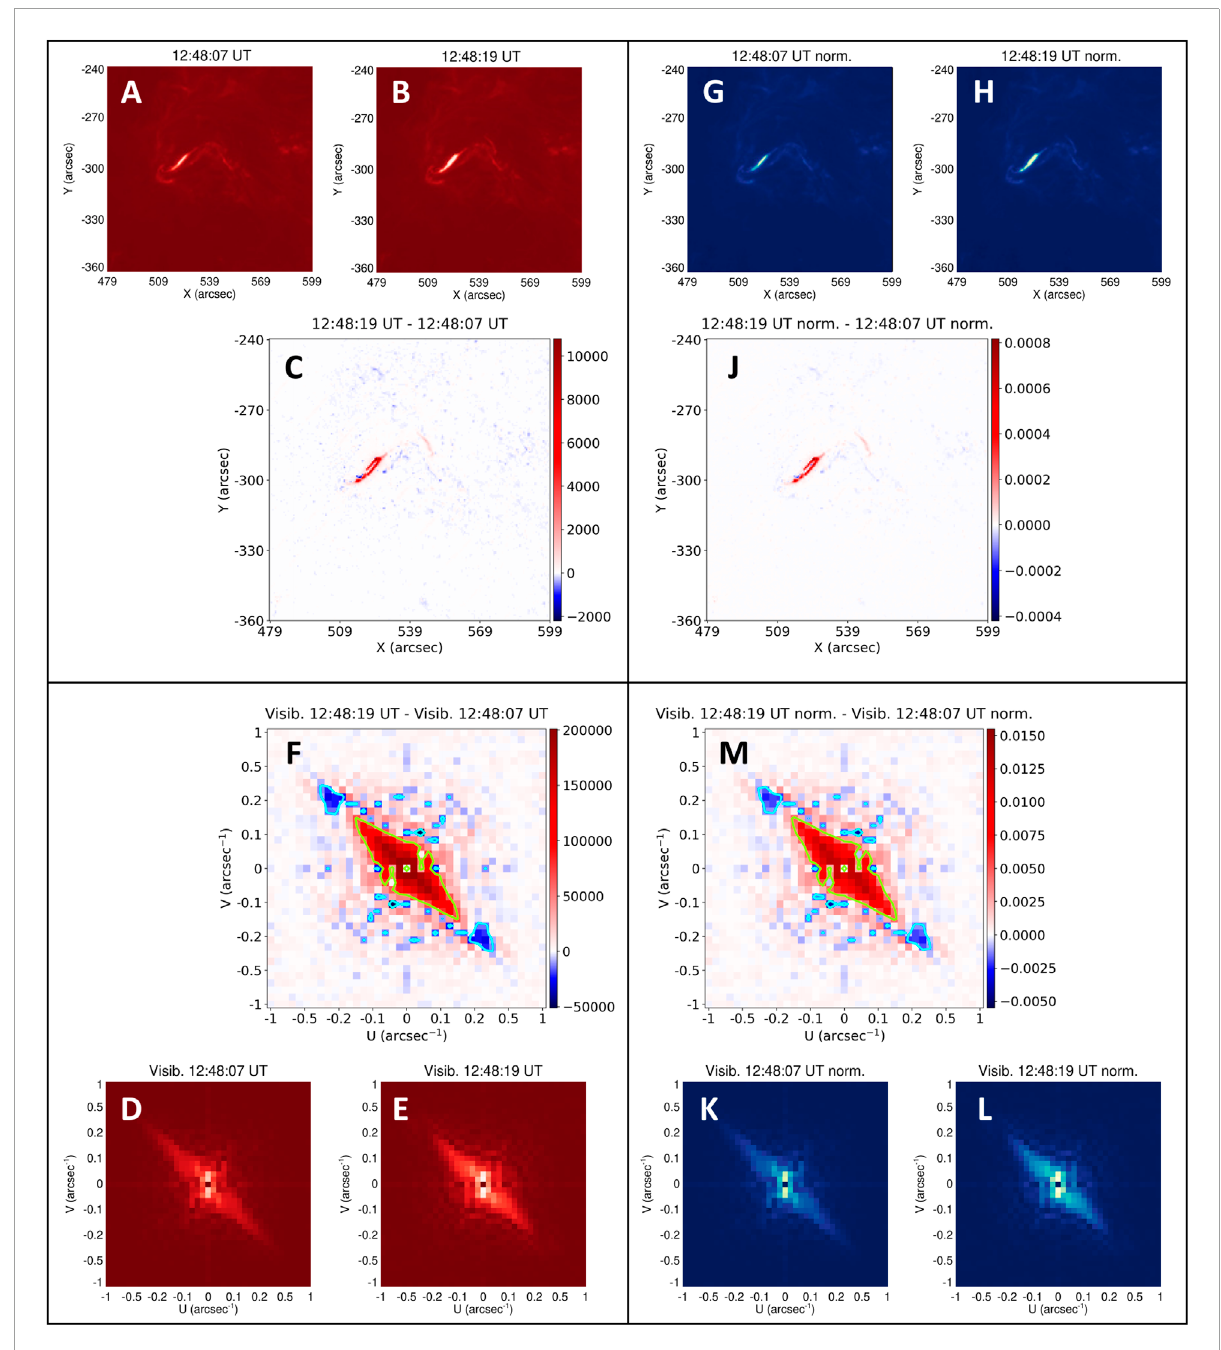
FIGURE 9 Top left quadrant: 304 Å images at 12:48:07 UT (A) and 12:48:19 UT (B) , and their difference image [ (B) – (A) ] (panel (C)) . Bottom left quadrant: Visibility amplitude maps (D) and (E) corresponding to maps (A) and (B) , respectively, and their difference [ (E) – (D) ] (panel (F)) . Top right quadrant: Normalized intensity maps (G) and (H) , corresponding to images (A) and (B) , respectively, and their difference [ (H) – (G) ] (panel (J)) . Bottom right quadrant: Visibility amplitude maps (K) and (L) corresponding to the normalized intensity maps (G) and (H) , respectively, and their difference [ (L) – (K) ] (panel (M)) . Contour levels corresponding to 20% of the minimum (negative) value (light blue) and 33% of the maximum value (light green) are overlaid in each of the visibility difference maps (F) and (M) . Specifically, the light blue contours correspond to values of − 9 , 900 (panel (F) ; un-normalized) and − 0 . 001 ((panel (M) ; normalized), while the light green contours correspond to values of 66,000 and 0.004,